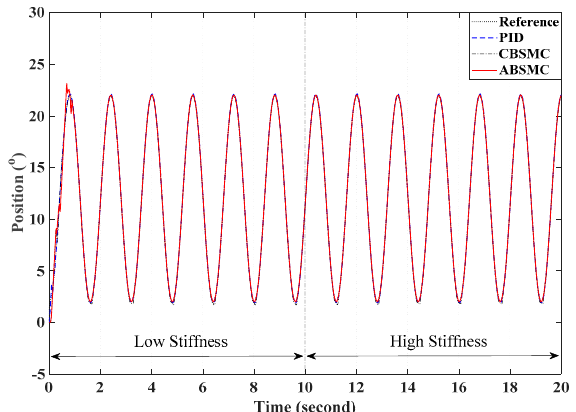
Figure 7. The angular displacement responses of the manipulator with the PID control, the CBSMC, and the proposed ABSMC.